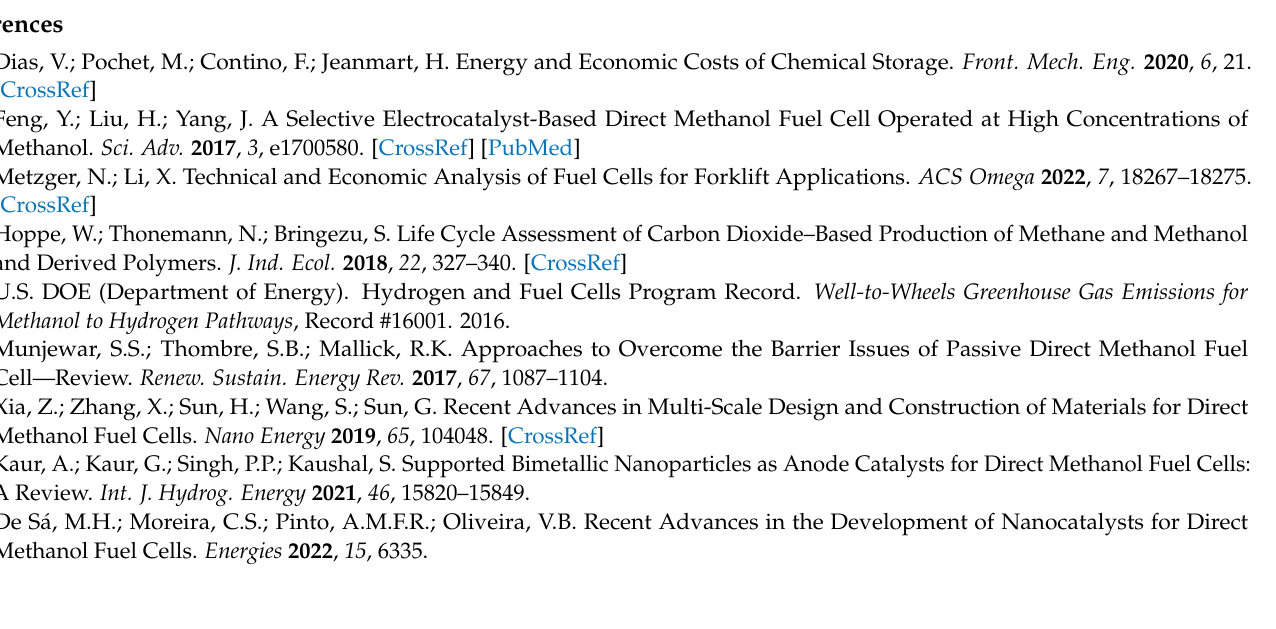
Figure S3: Polarization and power density curves related to a single module DMFC of 1 cm 2 as active area, employing Nafion ® 212, operating at 50 ◦ C fed with 2 M methanol aqueous solution at the anode and oxygen at the cathode; Figure S4: Polarization and power density curves related to a single module DMFC of 1 cm 2 as active area, employing CS/PTA with TiO 2 (5%) as electrolyte, operating at 50 ◦ C fed with 2 M methanol aqueous solution at the anode and oxygen at the cathode, recorded after 9 h of potentiostatic stability